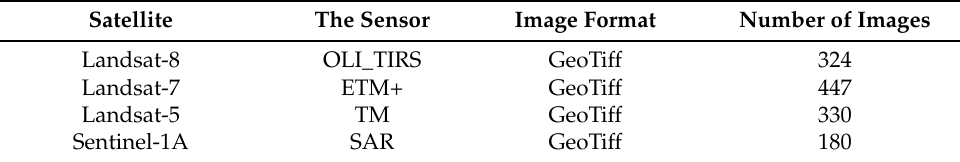
Table 1. Summary of all kinds of data used in the experiment.